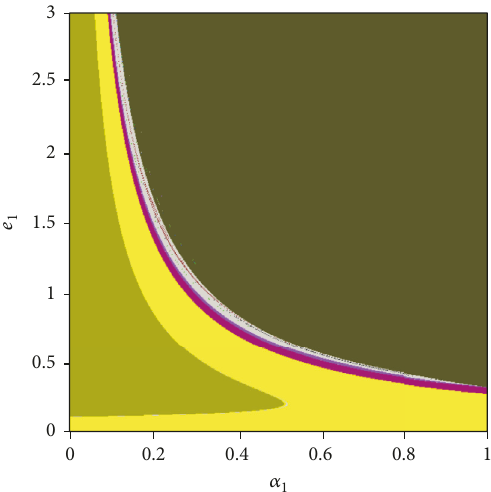
Figure 7: (𝑒 1 , 𝛼) -2D bifurcation diagram with 𝛽 = 0.1 and 𝛾 = 0.2 .